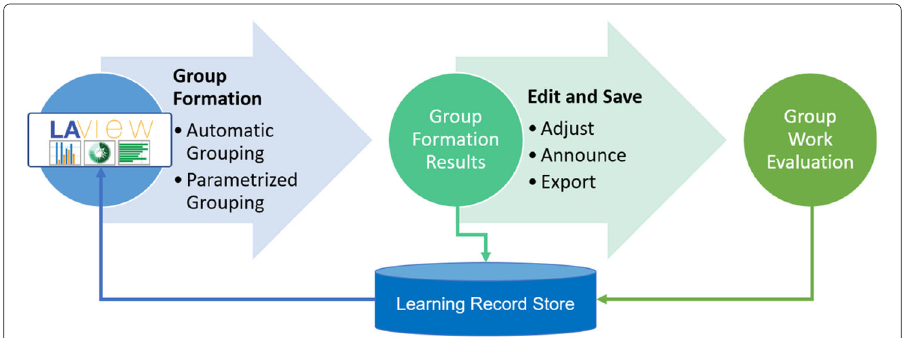
Fig. 3 User workflow of the group work